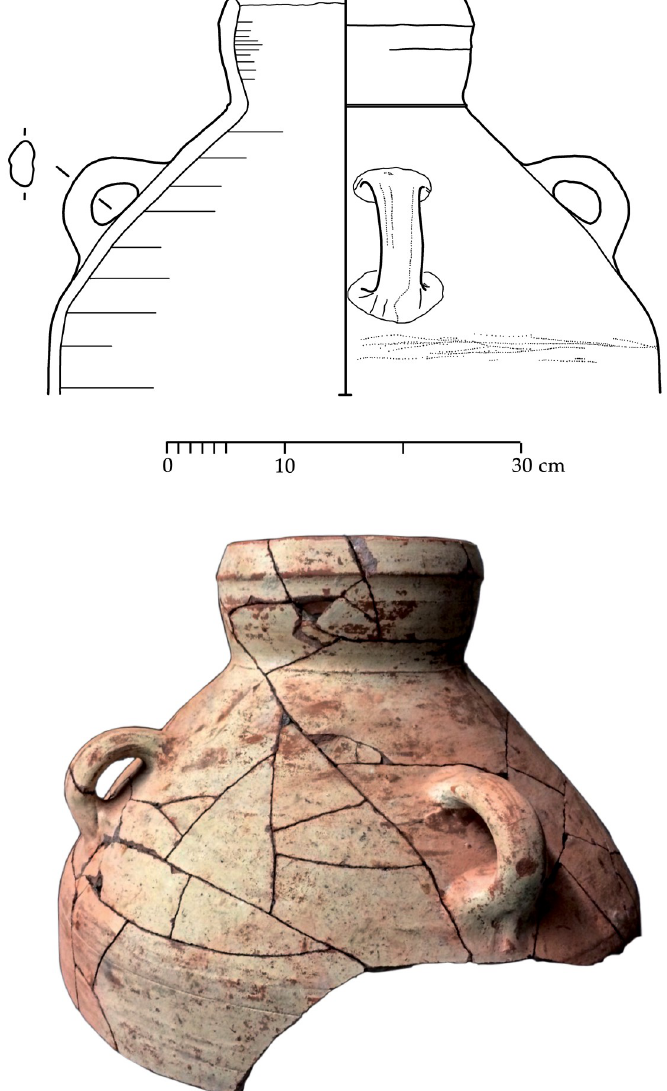
Fig 49. Large Storage jar with four handles, S/8098/8469, Nile G6a, white slip. the joint. Four evenly spaced vertical handles sit on the lower shoulder just above the carina- tion. An additional whitish slip covers the outside of the jar and the inside of its rim. Not bur- nished, it was fired to a whitish to pink colour. The hardness of the pottery suggests high firing temperatures. This should, in combination with the slip, increase the vessel´s density and pos- sibly prevent rapid evaporation of liquids. Like many other storage vessels, it possibly was used to store all kinds of goods. At Sidon the jar was probably used as a large water container. It was found sunken into a small plastered platform with raised edges. These very likely served to collect some of the water that diffused through the vessel´s wall, cooling the jars content during this process. Close by a small scoop made of alabaster was found, which seemed to be connected to the use of this jar.